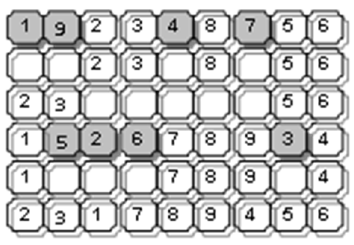
Figure 9. The LOX procedure.